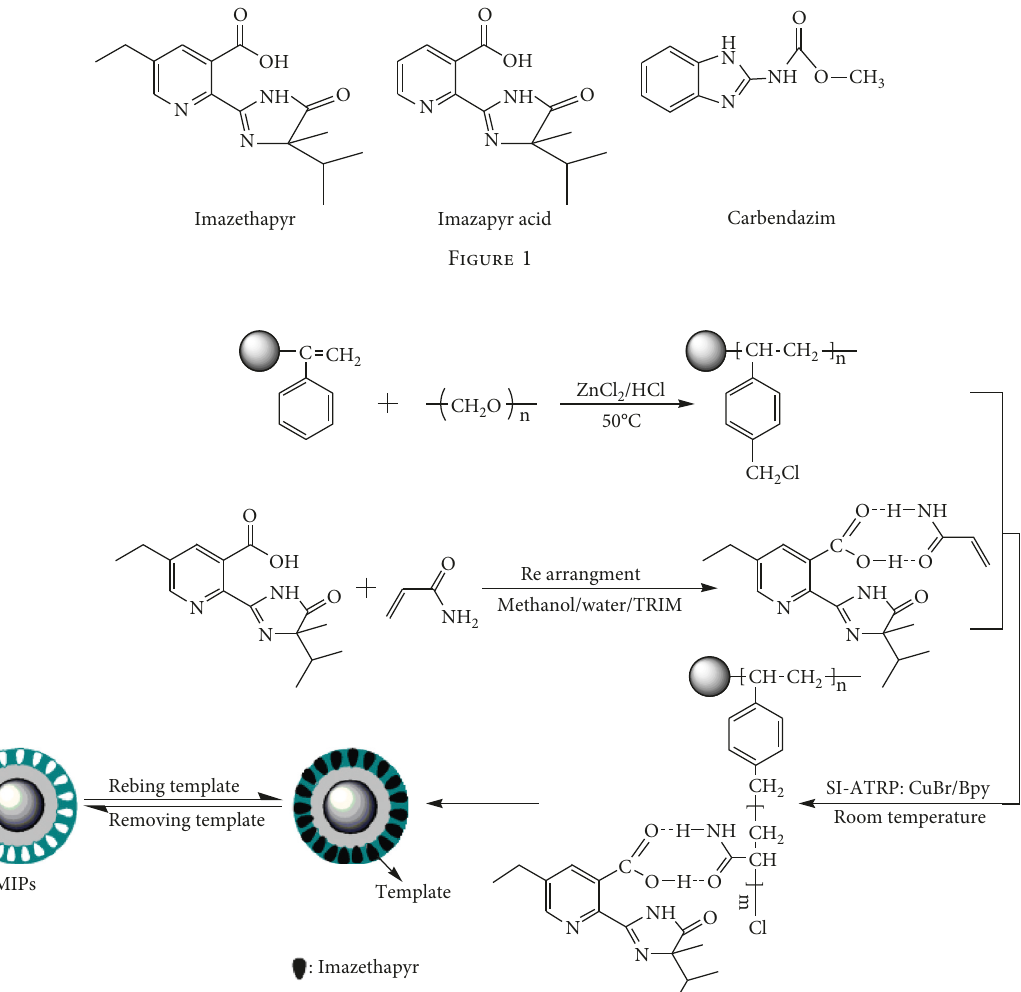
Figure 2: Process for preparing MIPs of